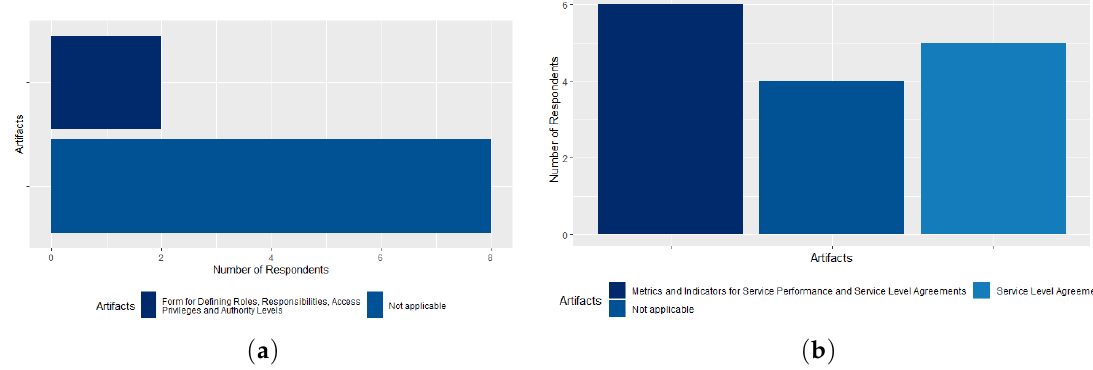
Figure 11. ( a ) The Business Process Modeling (Automated/to be automated) process artifacts; ( b ) the Computerized Systems Catalog (ICT Services Catalog) process artifacts.